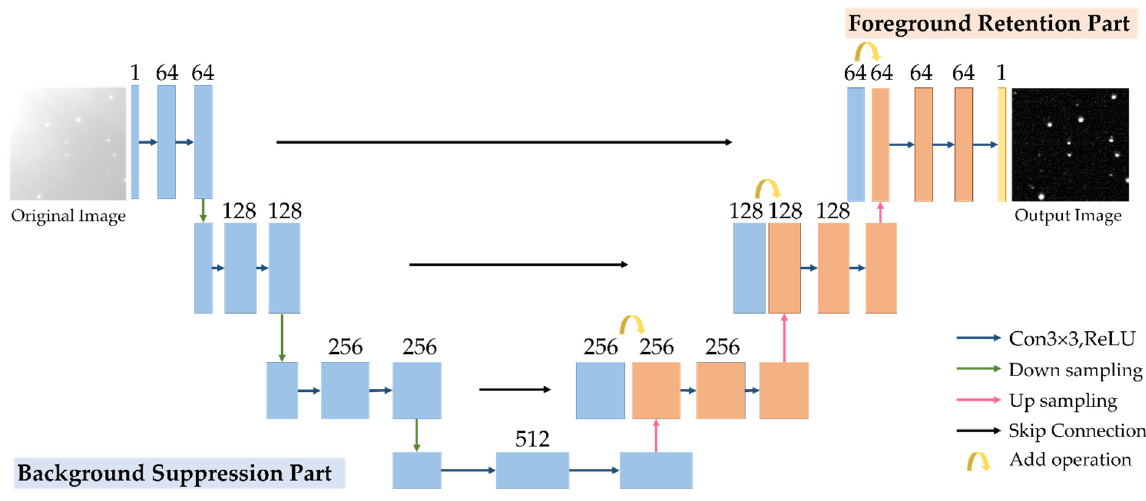
Figure 3. The network structure diagram of BSC-Net.